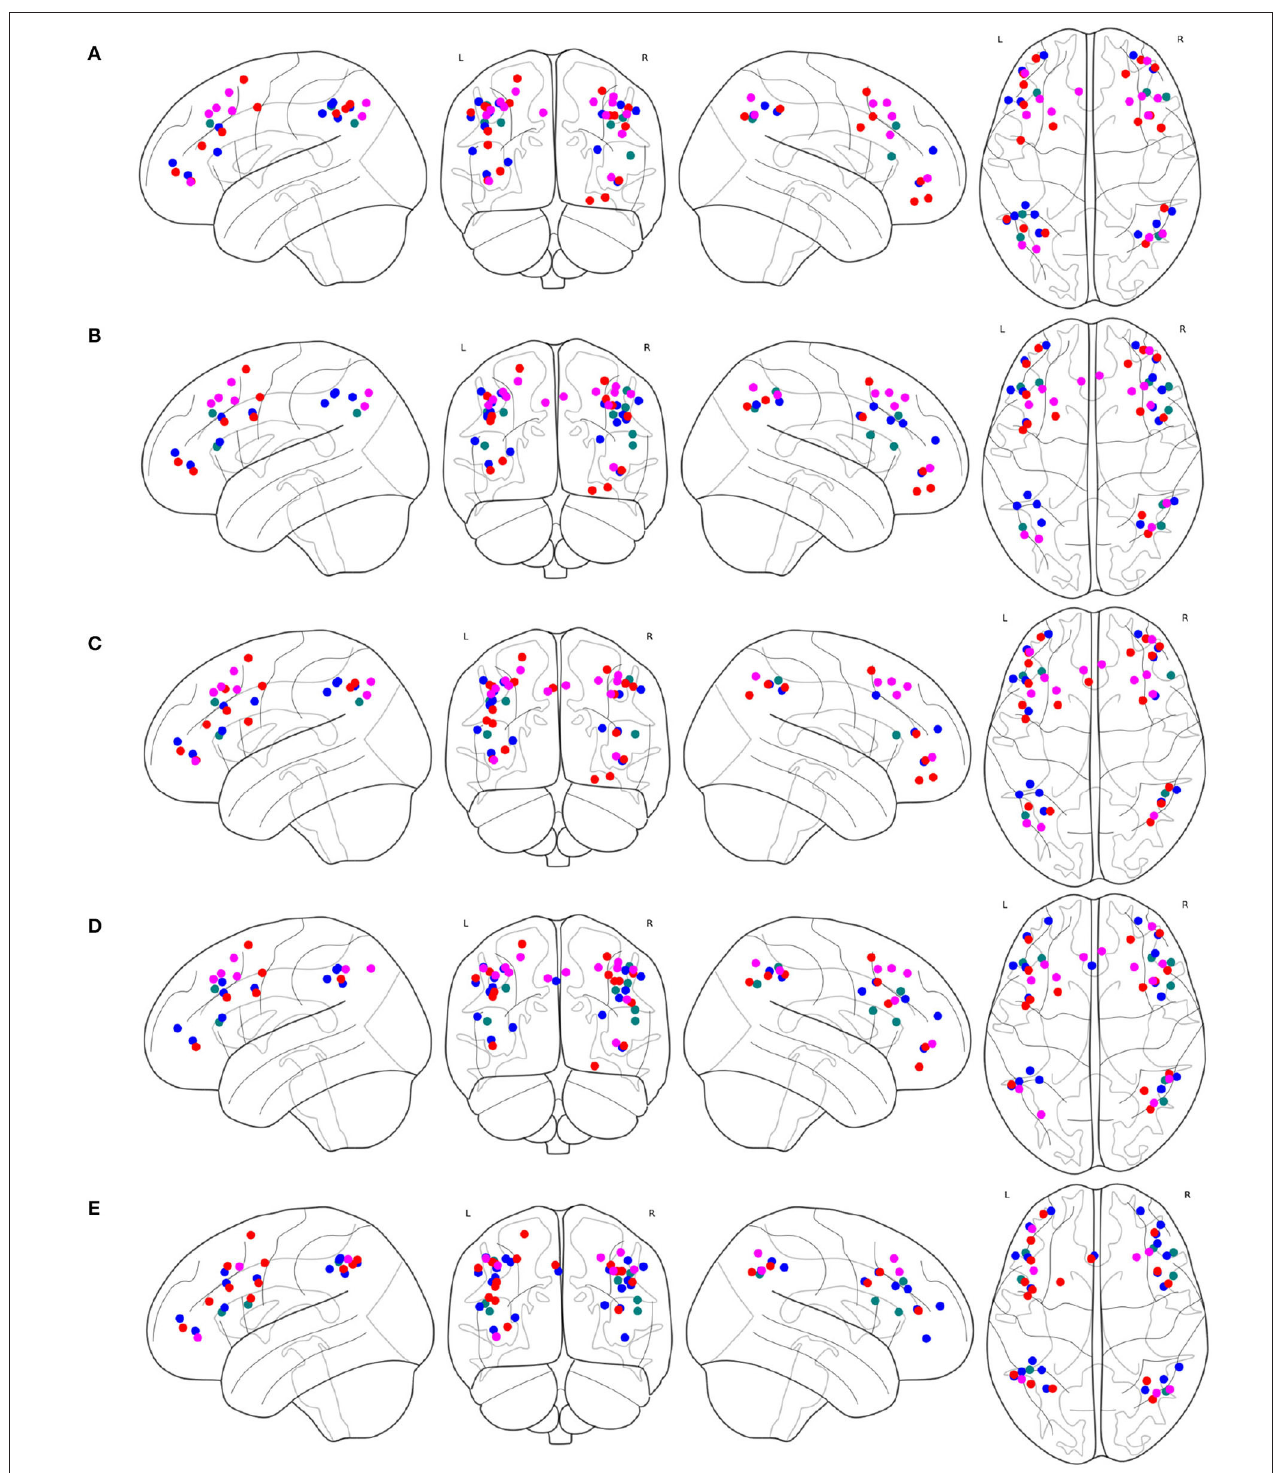
FIGURE 8 | FPNs with 51 ROIs calculated by different methods. ROIs with colors teal, blue, red, magenta come from AAL, Dosenbach-160, Power-264, and Willard-499, respectively, (A) 6, 14, 17, and 14 ROIs are selected by ExtraTrees from the four brain atlases, respectively, (B) 8, 17, 13, and 13 ROIs are selected by AdaBoost from the four brain atlases, respectively, (C) 5, 15, 18, and 13 ROIs are selected by RandomForest from the four brain atlases, respectively, (D) 7, 17, 14, and 13 ROIs are selected by XGB from the four brain atlases, respectively, (E) 7, 21, 16, and 7 ROIs are selected by the cognitive networks fusion algorithm from the 4 brain atlases,